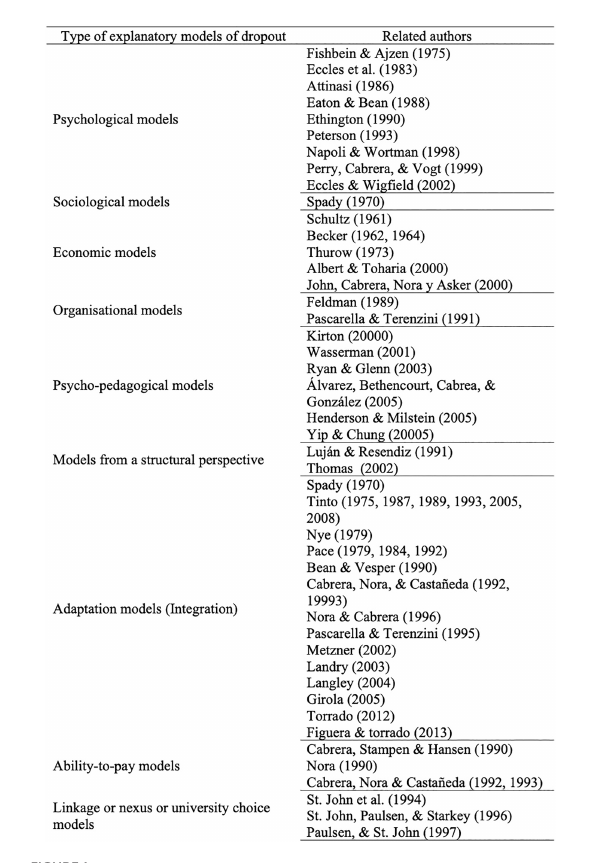
FIGURE 1 Dimensions grouping the explanatory models of dropout and authors related to each dimension. From Berlanga